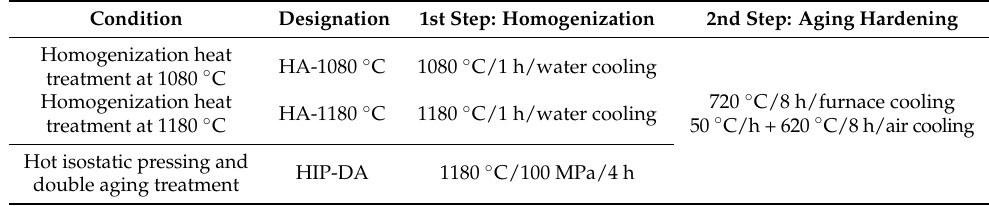
Table 1. Heat treatment applied in the current